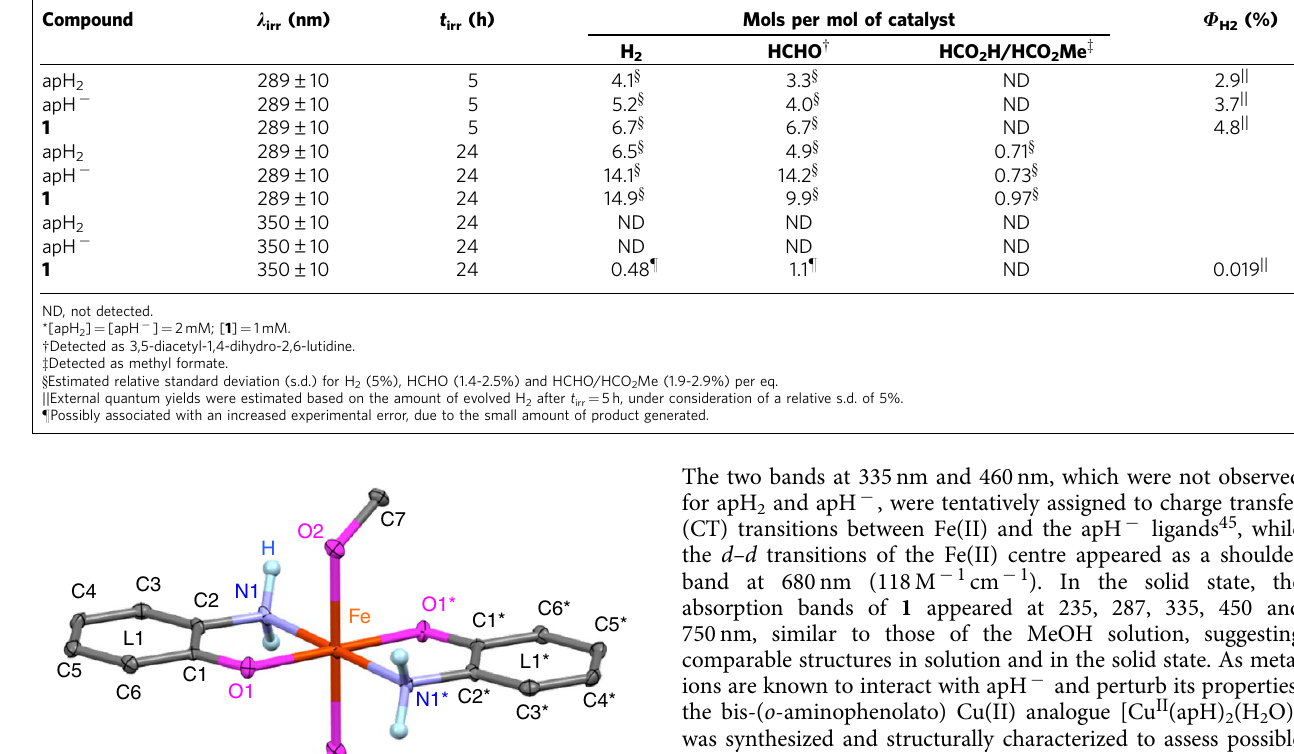
Table 1 | PHER products from the photochemical reactions of apH 2 -based photocatalysts*. Compound